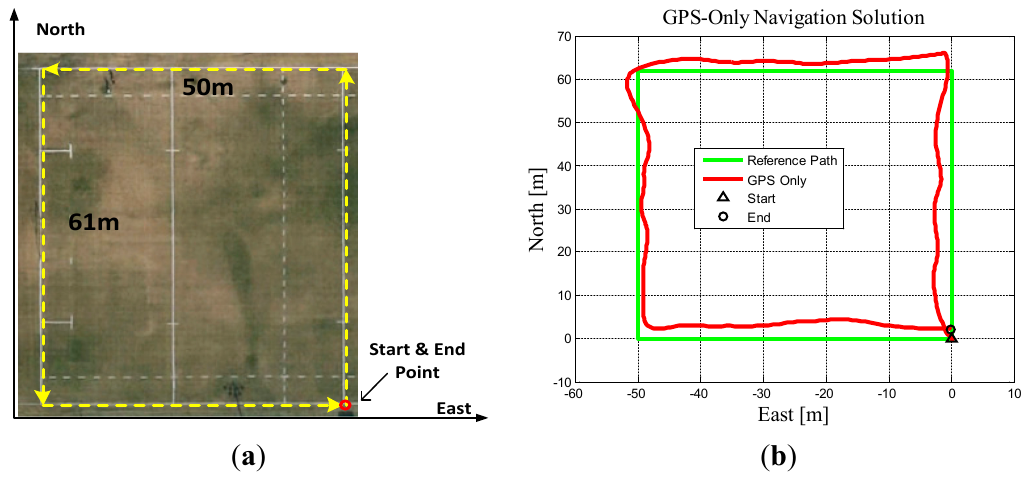
Figure 2. ( a ) Reference trajectory and ( b ) GPS (Global Position System) estimated trajectory (from Pedestrian Dead Reckoning/Global Navigation Satellite System (PDR/GNSS)